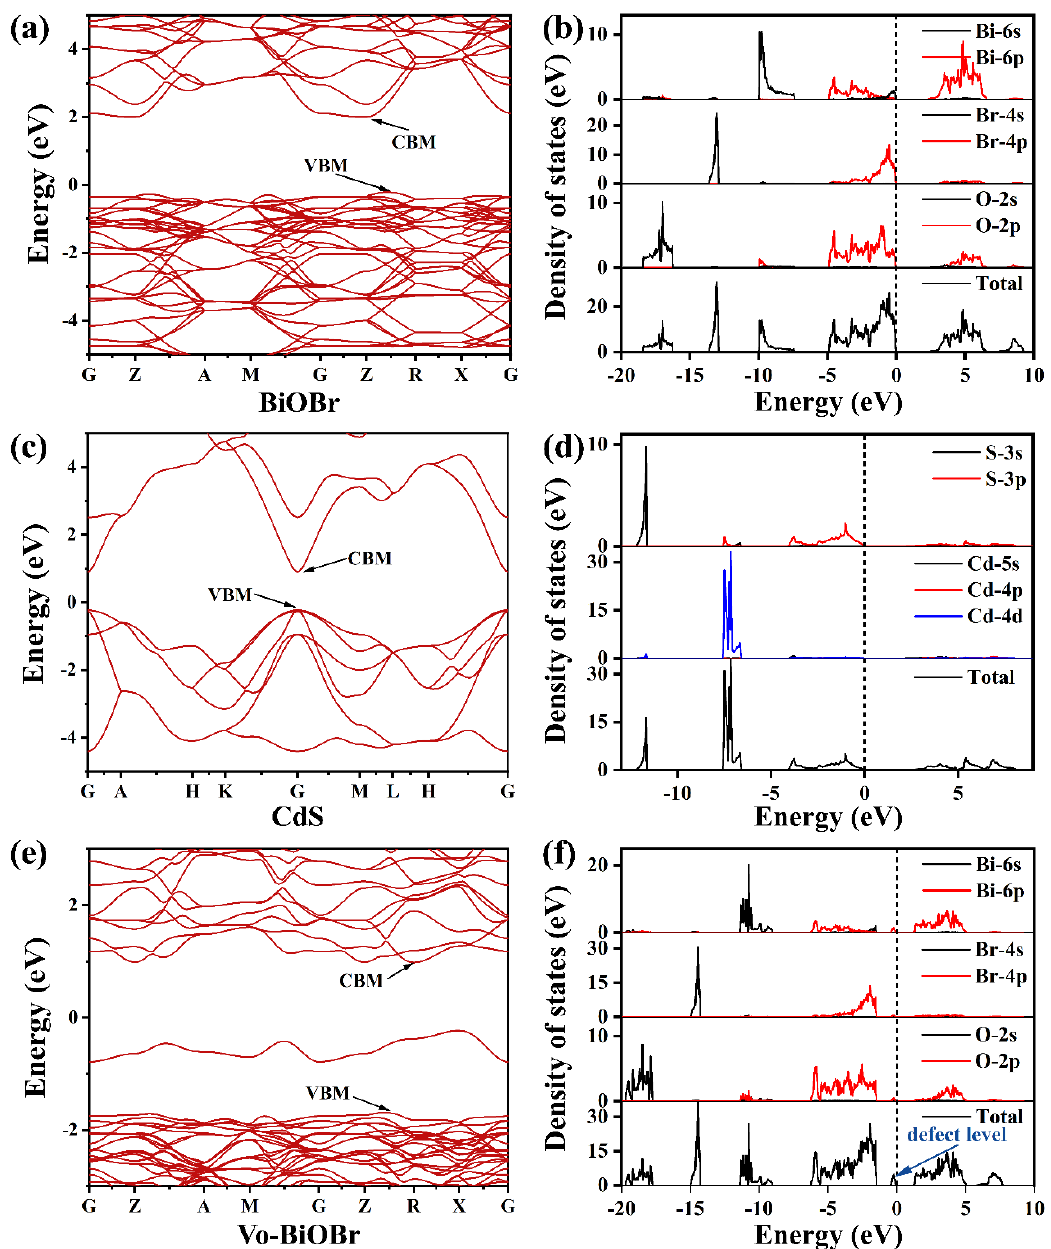
Figure 9. Calculated band structure and density of states of ( a , b ) BiOBr, ( c , d ) CdS, and ( e , f ) Vo-BiOBr.